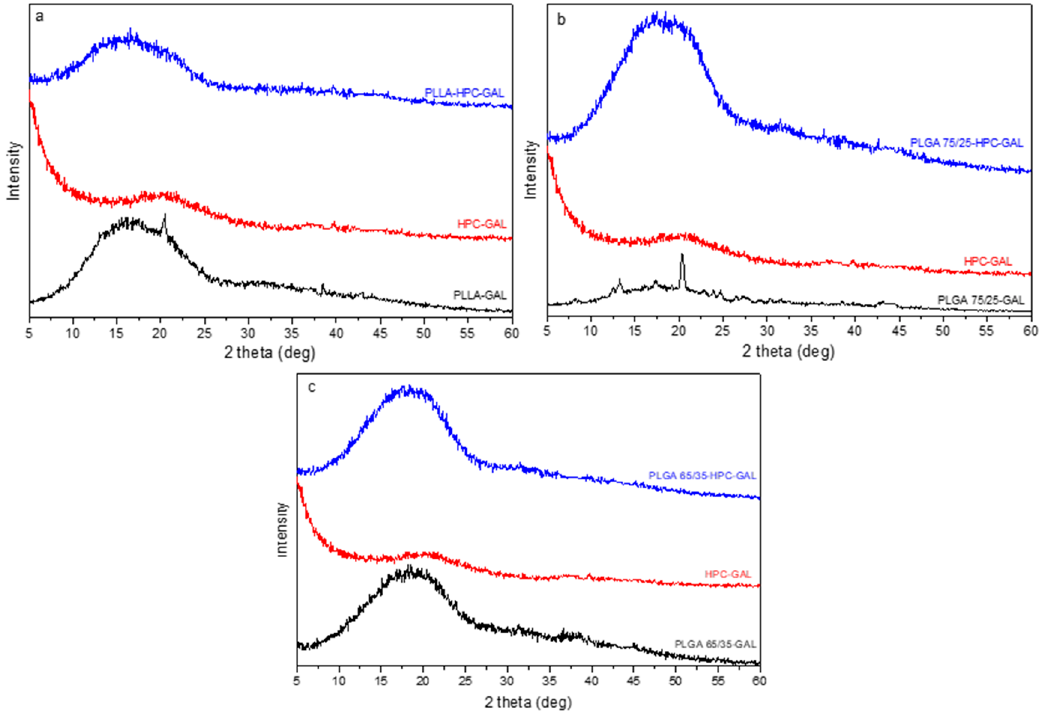
Figure 9. XRD patterns of nanoparticles with HPC–GAL. ( a ) PLLA–HPC–GAL, ( b ) PLGA 75/25– HPC–GAL, and ( c ) PLGA 65/35–HPC–GAL. –GAL, and ( c ) PLGA 65 /